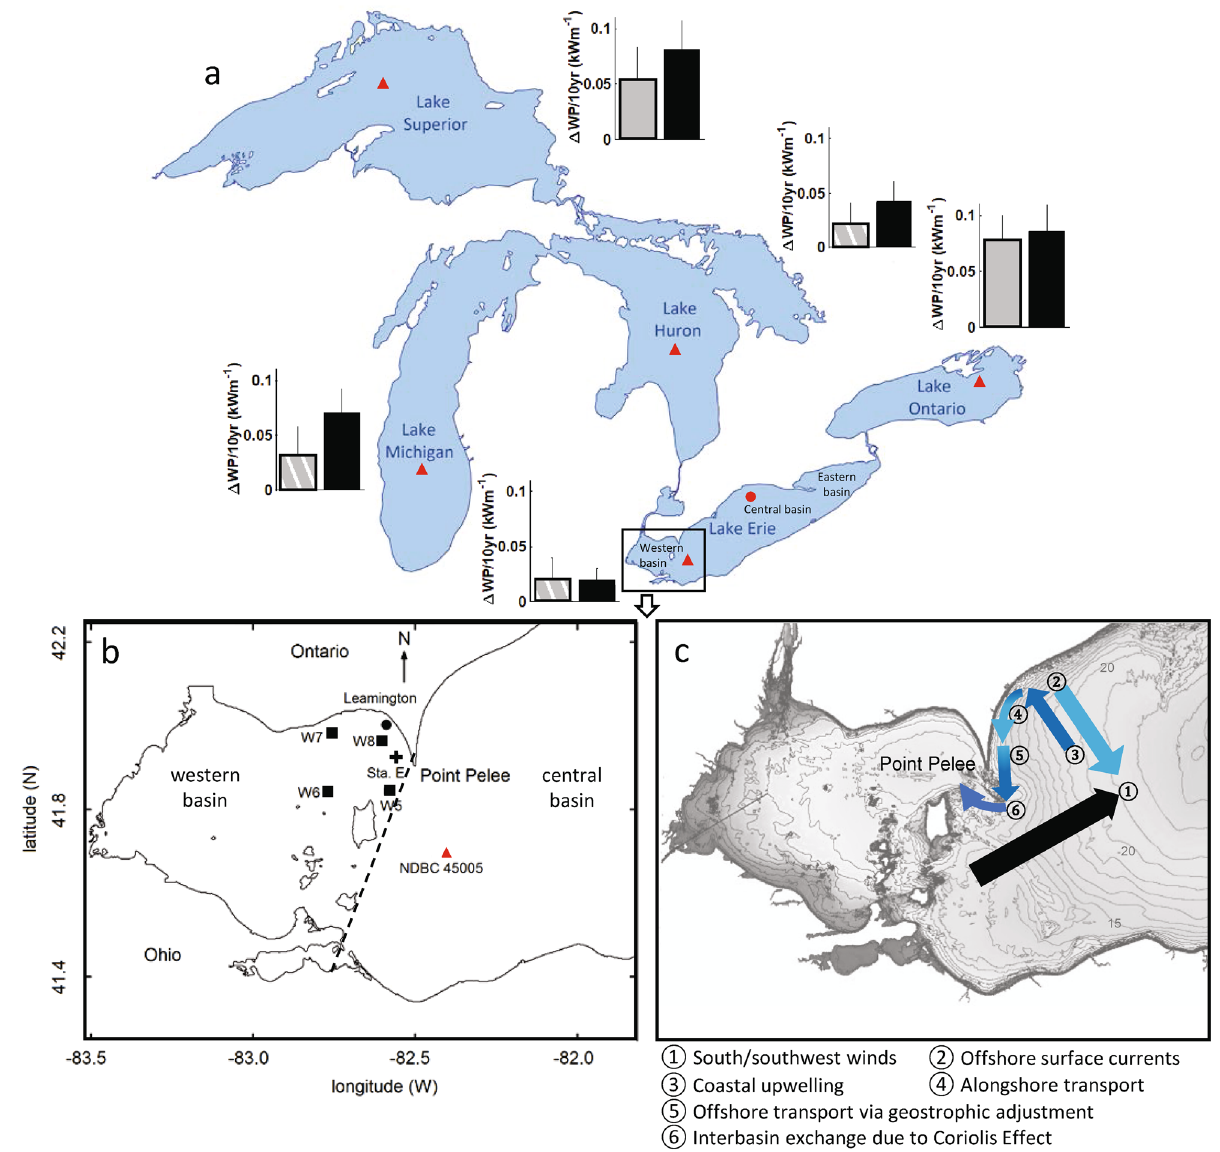
Figure 1. Map of Great Lakes and stations in this study. ( a ) Map of the Laurentian Great Lakes with the location of weather and wave buoys (red triangles) and the location of the western basin indicated in the outline. The grey and black bars show the rate of increase in wave power during August (grey) and August during winds from the south and southwest direction (black) between 1980 and 2018 (Supplementary Table 1). The length of the error bars shows the standard error. The hatched grey bars indicate relationships that are not statistically significant (i.e., p > 0.05); all the black bars are significant (i.e., p < 0.05). The red circle in Lake Erie is the location of the weather and wave buoys near Port Stanley (Supplementary Table 1). ( b ) Western basin of Lake Erie with the location of the bottom water temperature ( LBT ), dissolved oxygen ( DO ), and water current measurements in 2017 22 and 2018 (indicated by + symbol; Sta. E: 41.9398 ∘ N, 82.5527 ∘ W). The red triangle (41.677°N, 82.398°W; 9.8 m depth) is the weather and wave Sta. NDBC 45005. The circle (42.01567°N, 82.58185°W; 4.1 m depth in Leamington, ON) is the location of the water temperature time series measurements (1998–2018; no data for 2012) from the Ontario Ministry of Natural Resources and Forestry (MNRF) and the squares are the locations of limnological records from biweekly sampling cruises (bottom dissolved oxygen 2007–2018; total phosphorus 2000–2018) conducted in August by MNRF (W5: 41.8832°N, 82.613°W, W6: 41.8545°N, 82.7623°W, W7: 41.9907°N, 82.7633 ∘ W, and W8: 41.9865°N, 82.5758°W). The dashed line in ( b ) indicates the boundary between the western and central basins. See Supplementary Table 2 for details of station locations and instruments used. ( c ) Schematic of the mechanism of upwelling and intrusion of hypolimnetic water from the central basin to the western basin. Winds from the south and southwest direction cause offshore surface currents (light blue) due to Ekman transport that result in coastal upwelling of hypolimnetic water (dark blue), which is entrained in the alongshore surface current. Following relaxation of the winds, the upwelled water sinks due to the pressure gradient and intrudes into the western basin due to the Coriolis effect (e.g., geostrophic adjustment). All maps were obtained from the National Centers for Environmental Information (NCEI), National Oceanographic and Atmospheric Administration (NOAA) (https ://www.ngdc.noaa.gov/mgg/great lakes /). ( c ) is modified from https ://www.ngdc.noaa.gov/mgg/great lakes /erie.html with bathymetry contours provided in